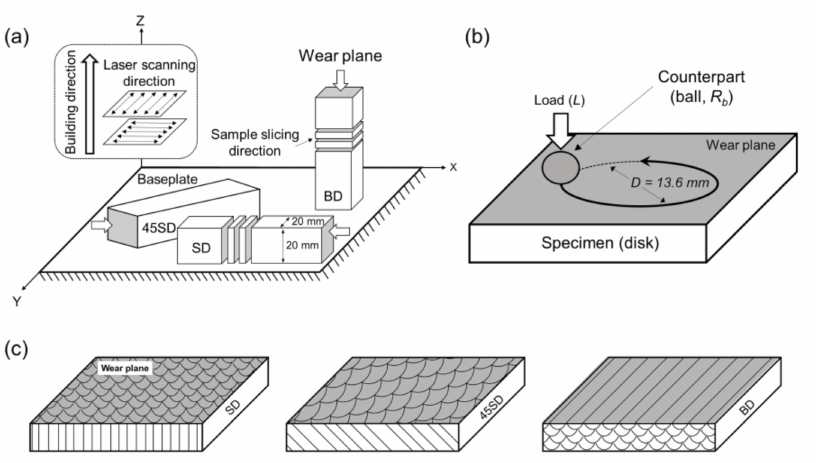
Figure 1. ( a ) Schematic of sample geometries, LPBF scanning strategy, building direction, and wear test directions, ( b ) schematic of the ball-on-disk wear test system, and ( c ) schematic of each sample and wear